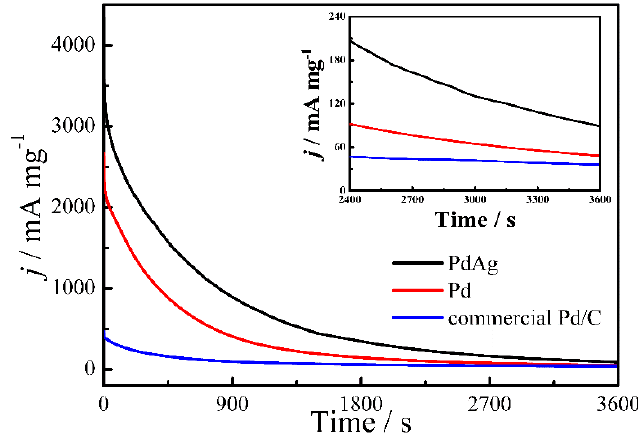
Figure 5. Chronoamperograms of the as ‐ prepared catalysts for 1.0 M C 2 H 5 OH on 1.0 M KOH solution at − 0.3 V.